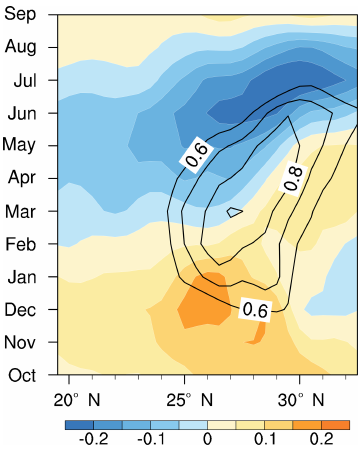
Figure 3. Latitude–time section of the climatological monthly mean gradient magnitude (GM) of the NPSTF (black con- tour; units: ◦ C(100km) − 1 ) and its tendency (shading; units: ◦ C(100km) − 1 month − 1 ), averaged zonally over 140 ◦ E–170 ◦